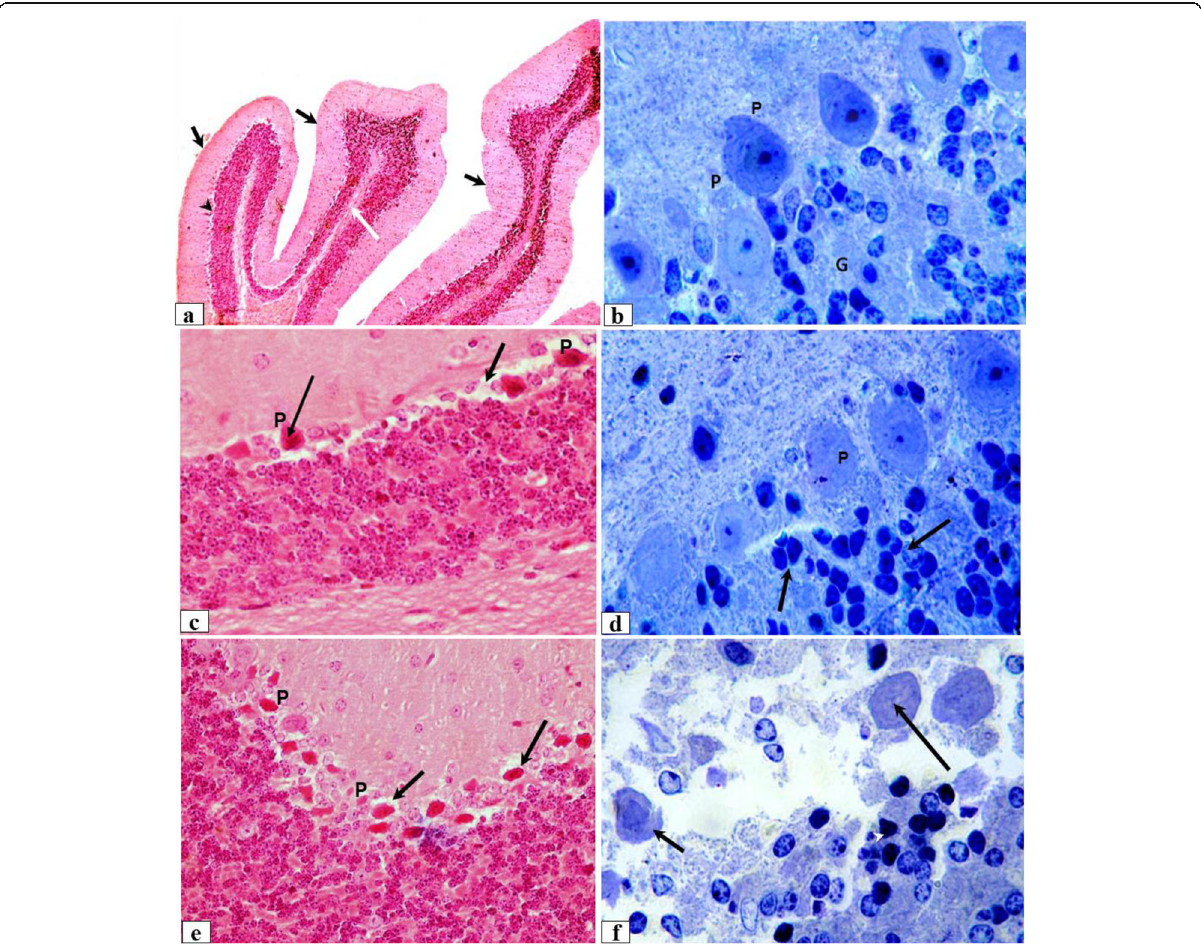
Fig. 3 a – f Light micrograph of sections of the cerebellar cortex of the cerebellum. a Control mice showing the folium (arrows) of the gray matter. H&E, × 100 (bar = 200 μ m). b Semithin section showing the flask-shaped of Purkinje cells (P). Toluidine blue, × 1000 (bar = 20 μ m). c Mice intraperitoneally injected with 5mg/kg bw cisplatin showing shrunken Purkinje cells (P) and halo of empty spaces around the Purkinje cells (arrows), × 400 (bar = 50 μ m). d The nuclei of some Purkinje cells (P) are hardly identified. Note the dense nuclei of the granular cells (arrows). Toluidine blue, × 1000 (bar = 20 μ m). e Mice treated with 10mg/kg bw cisplatin showing deposition of the Purkinje cells (P) surrounded by a highly vacuolated cytoplasm (arrow), × 400 (bar = 50 μ m). f Disorganization of the Purkinje cells with hardly identified nuclei (arrows). Toluidine blue, × 1000 (bar = 20 μ